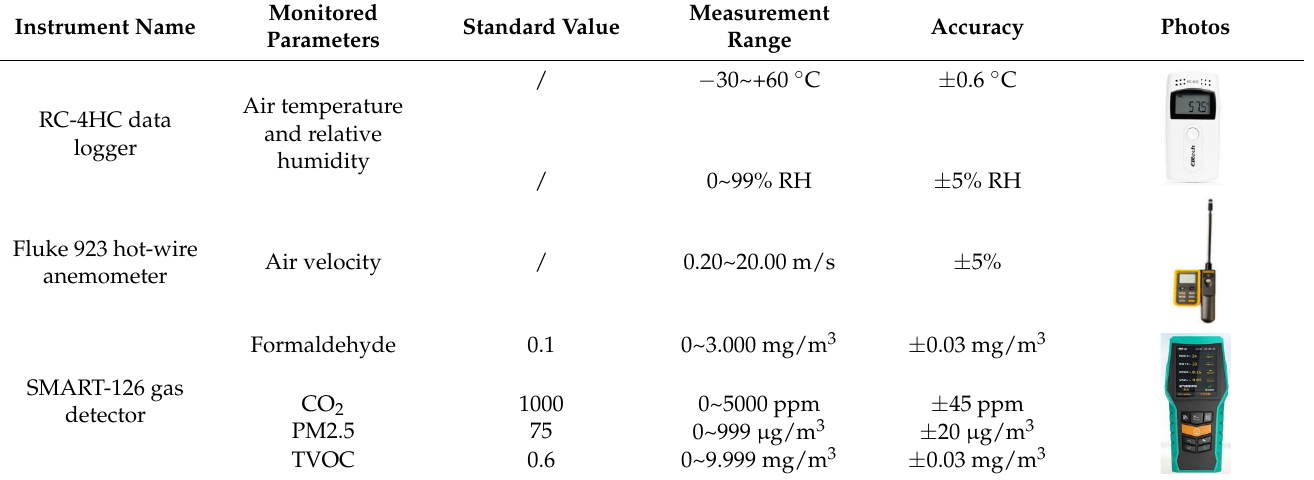
Table 1. Monitored data and technical specification of measuring instruments.